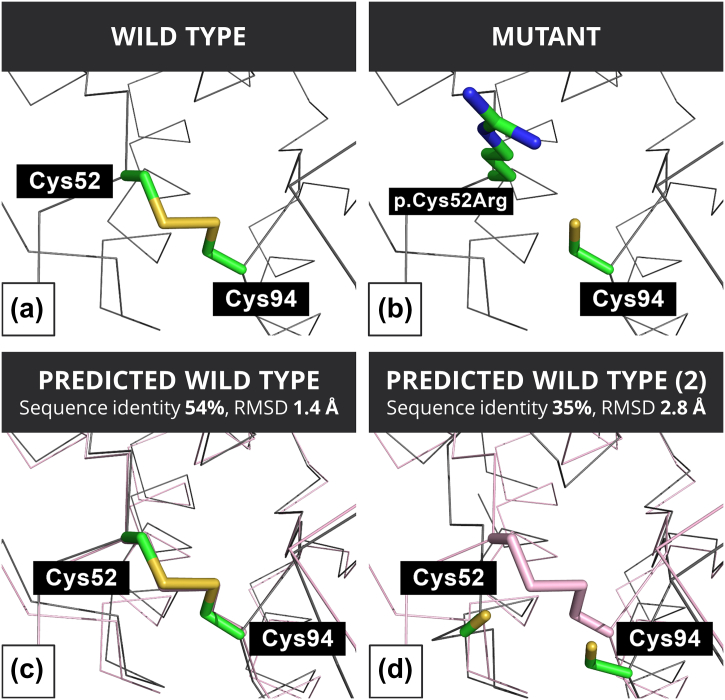
Structural analysis of variant p.Cys52Arg in the crystal and predicted structures of alpha-galactosidase. (a) Cys 52 in the wild type, (b) Arg 52 in the mutant modeled from the wild type, (c) Phyre2 wild-type predicted structure of the Cys 52 using a model with RMSD to the crystal structure of 1.4 Å (PREDICTED WILD TYPE) and (d) Phyre2-predicted wild-type structure of the Cys 52 using a model with RMSD to the crystal structure of 2.8 Å (PREDICTED WILD TYPE (2)). Color scheme for the four panels as in Fig. 7. In addition, the SG atoms are shown in yellow.